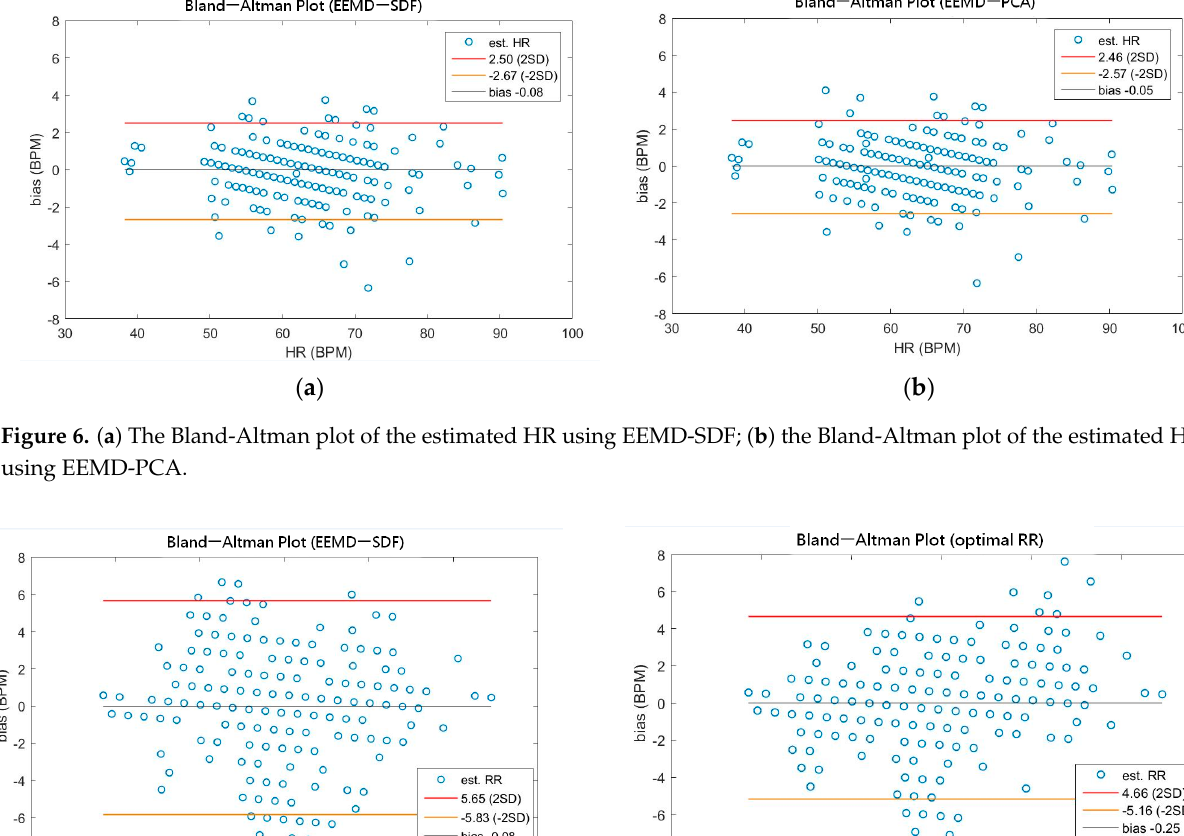
Sensors 2021 , 21 , x FOR PEER REVIEW